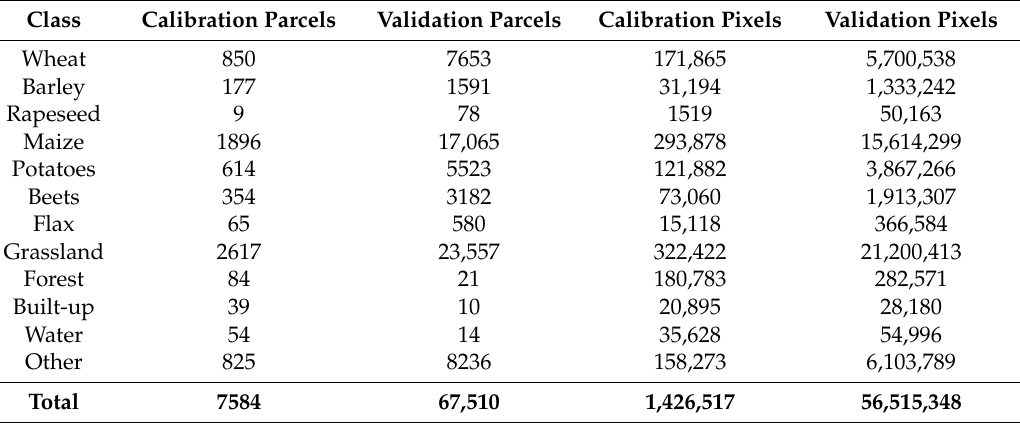
Table 1. Total number of calibration and validation parcels and pixels per